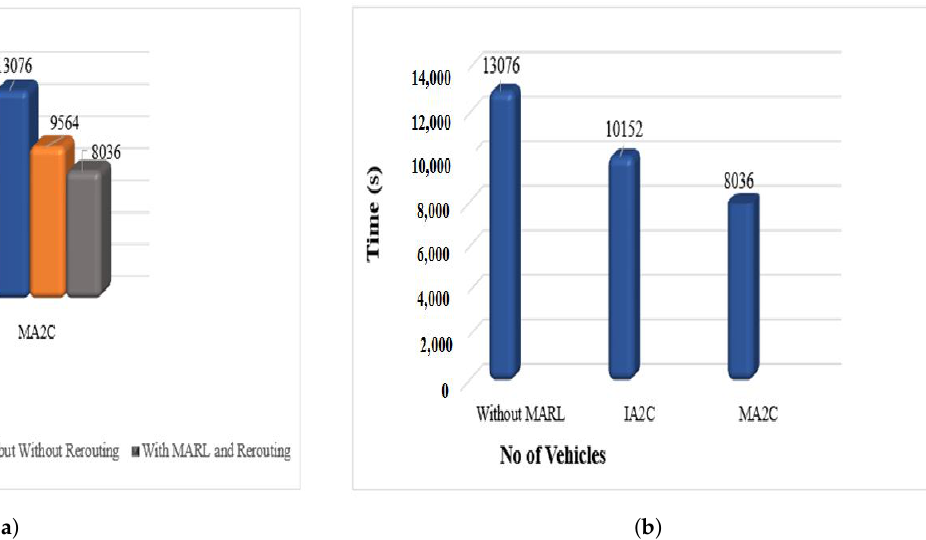
Figure 7. Comparisonresults of improved performance by our proposed approach. ( a ) Comparison with and without implementing MARL and Rerouting. ( b ) Comparison with and without implementing